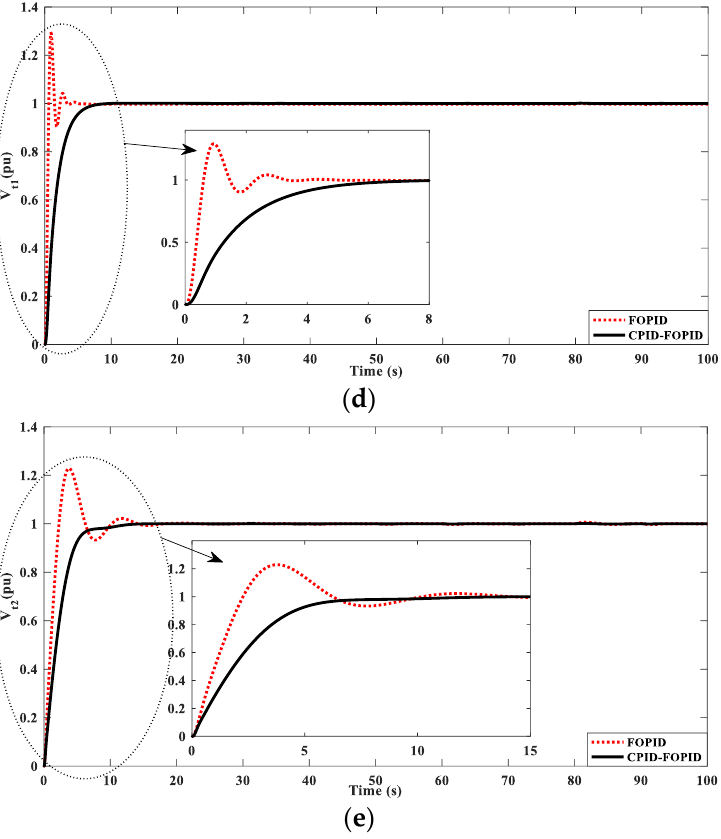
∆ f ∆ P 1 ; ( b ) 2 ; ( c ) tie ; ( d ) V t 1 ; ( e ) V t 2 . Figure 6. Dynamic responses with random patterns ( a ) ∆ f 1 ; ( b ) ∆ f 2 ; ( c ) ∆ P tie ; ( d ) V t1 ; ( e ) V t2 .